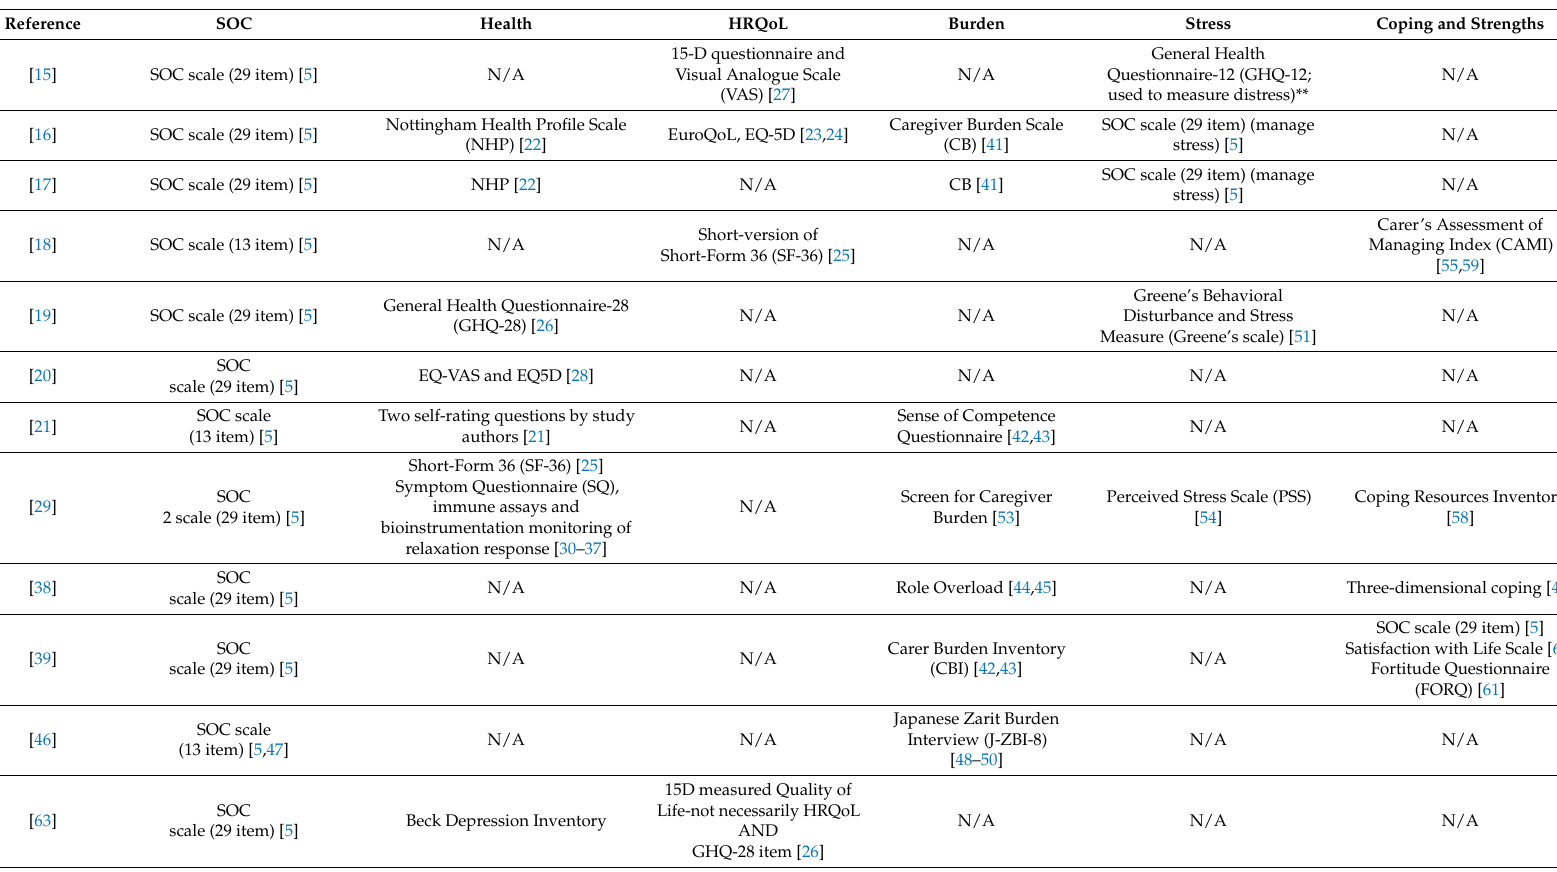
Table 4. Instruments identified in literature review (available psychometrics are included in Tables 1–3). SOC: sense of coherence; HRQoL: health-related quality of life; N/A: not applicable; EuroQoL EQ-5D: European Quality of Life scale. ** Distress may or may not be the same as